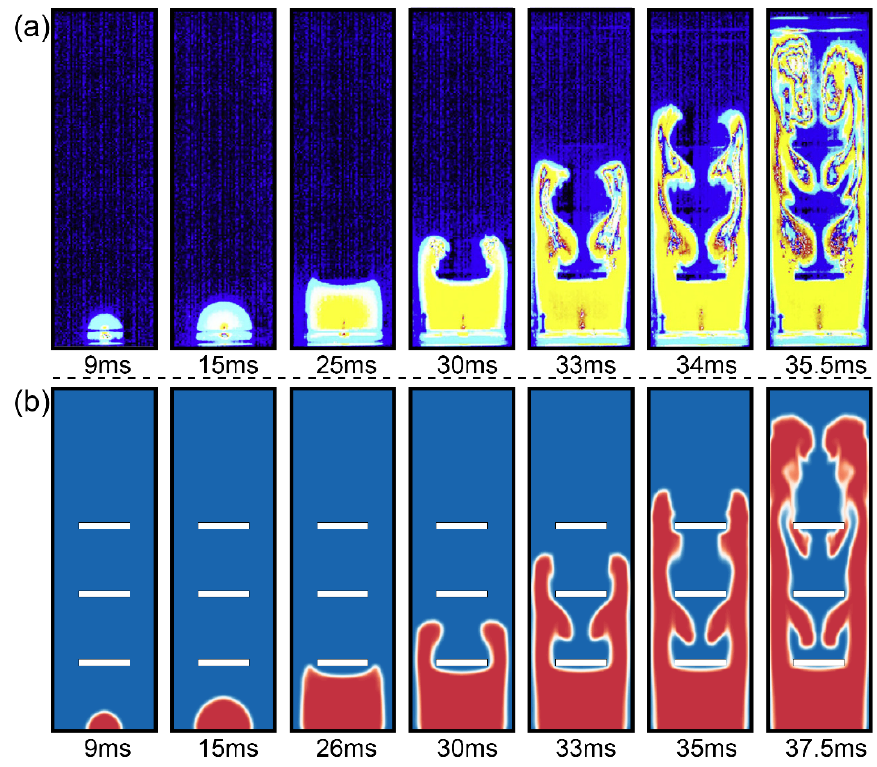
Figure 2. The rection progress of combustion: ( a ) Wen et al. [35]; ( b ) this study. According to the overpressure comparison curves from the Figure 3, the overpressure curves of LES were similar to the experiment with meshes of three different cell sizes before the peak value of the pressure. The decrease speed of the simulated pressure was slower than the experiment because the walls were set to be adiabatic and non-slip, so the high temperature could not shed heat from the closed tube after the peak value of the pressure [40]. There was a small pressure peak that might relate to the rupture process of the PVC membrane at the opening of the tube [4], such as the Pv in Figure 3. However, the simulated pressure did not appear as the small peak value because the PVC membrane wasn’t considered during the simulation process. From 40 ms to 48 ms, the burned and unburned premixed gas rushed out the tube with the rupture of the PVC membrane; there was negative pressure in the tube. The air outside the tube was drawn into the tube because of the pressure difference, so the unburned premixed gas inside the tube was burned again, which created a small pressure peak, such as the P H in Figure 3. With the disappearance of the premixed gas in the tube, the pressure of the content of the tube gradually drops to 0. The process of numerical simulation was simplified by covering the PVC membrane at the outlet; therefore, there was not such a small pressure peak and it slowly returned to zero